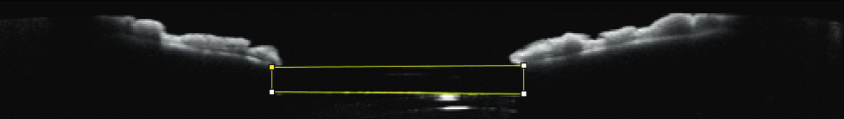
Figure 1: AS-OCTof a patient one month after FILSSF IOL implantation. Yellow boundary lines are drawn to calculate the angle between the implant and iris plane.